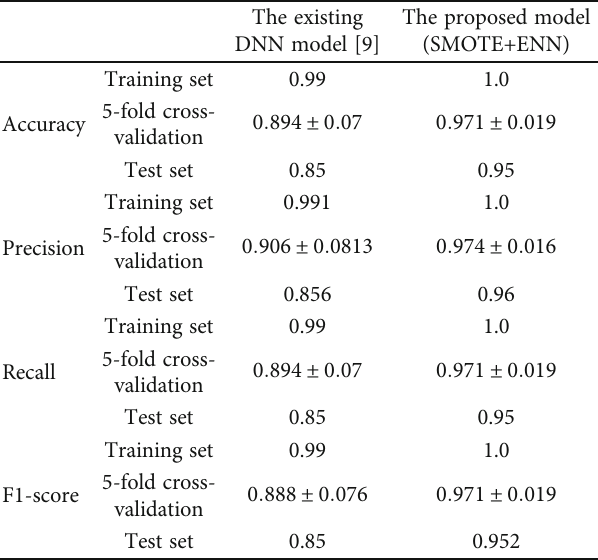
Table 4: The performance comparison of the existing DNN model [9] and the proposed